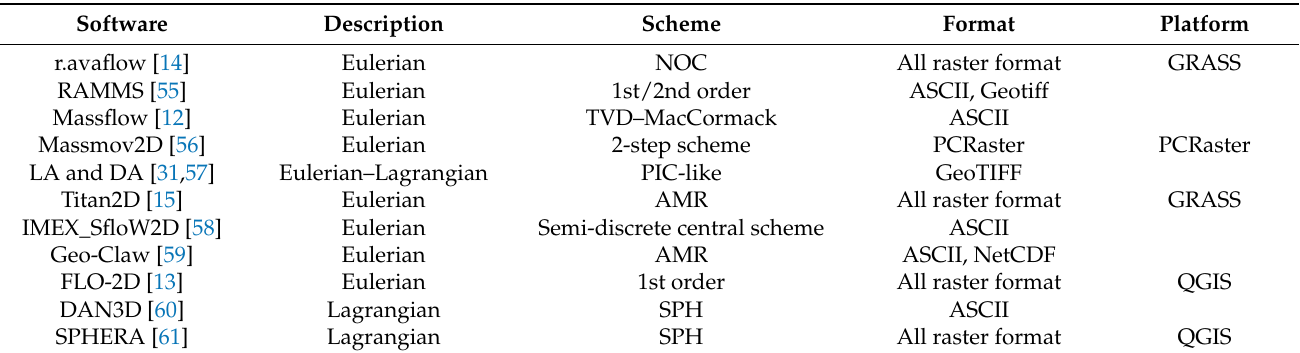
Table 2. Flow-like programs on GIS